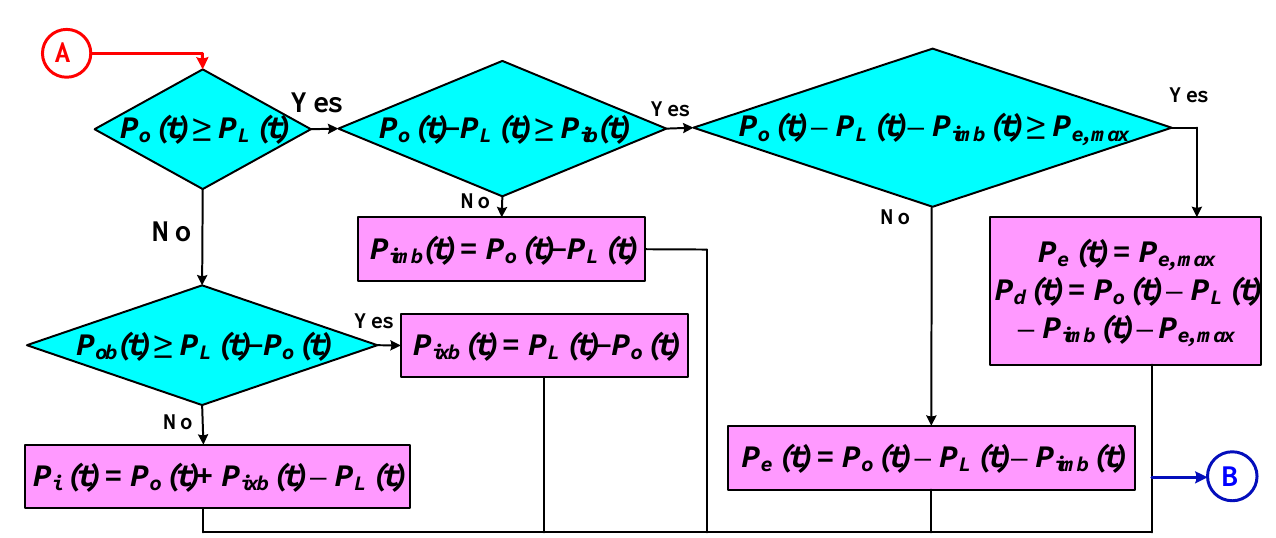
Figure 3. Rule-based home energy management system for PV-BESS system.